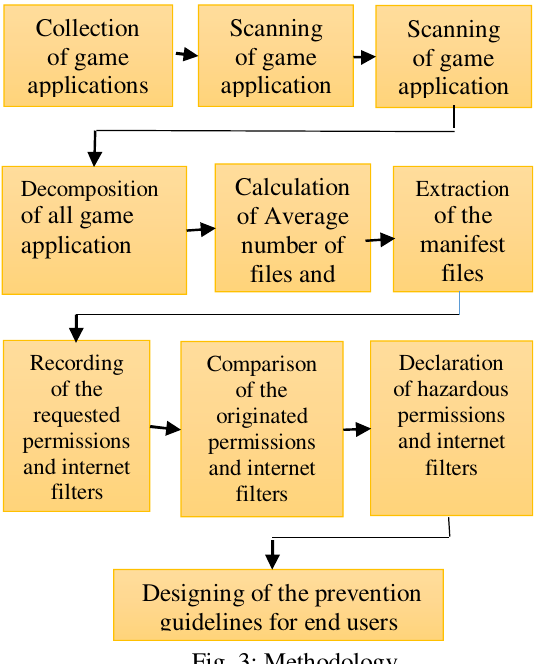
Fig. 3: Methodology